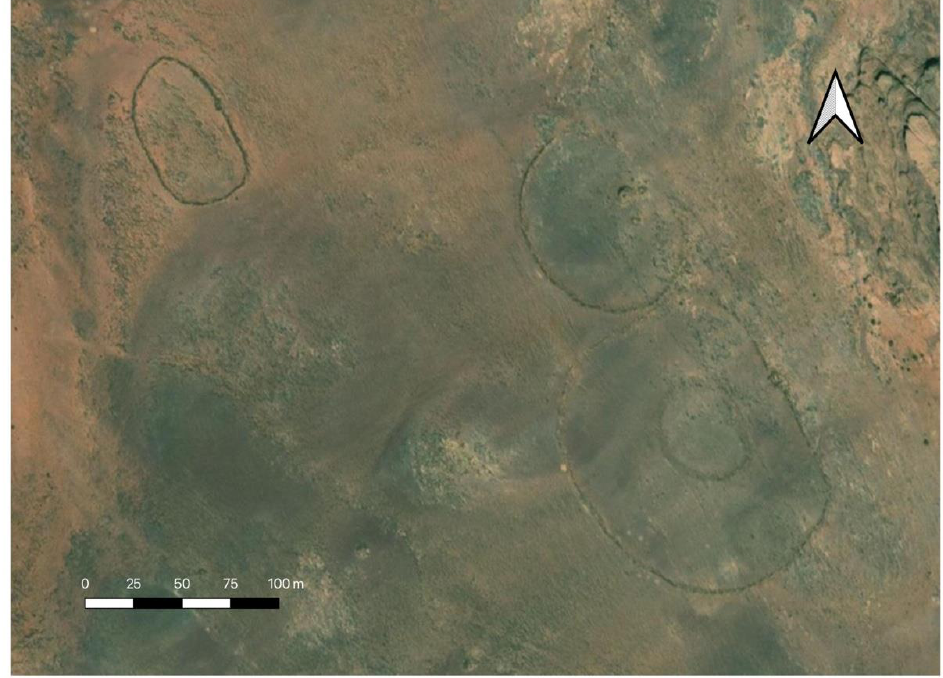
Figure 9. A cluster of ‘ringed enclosure’ structures. Source: Google Earth .